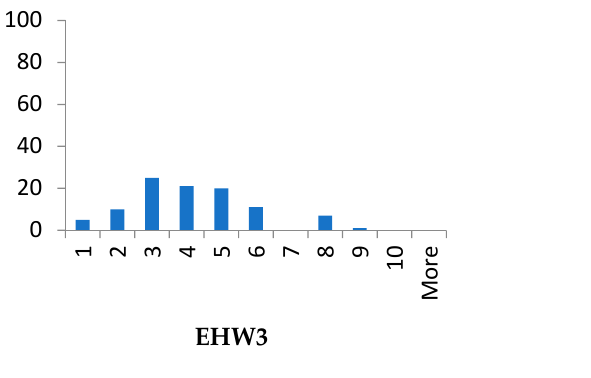
Figure 6. Histograms—Benchmark instance C. Table 11. Comparation of selected values—evolutionary and metaheuristic method for benchmark C.